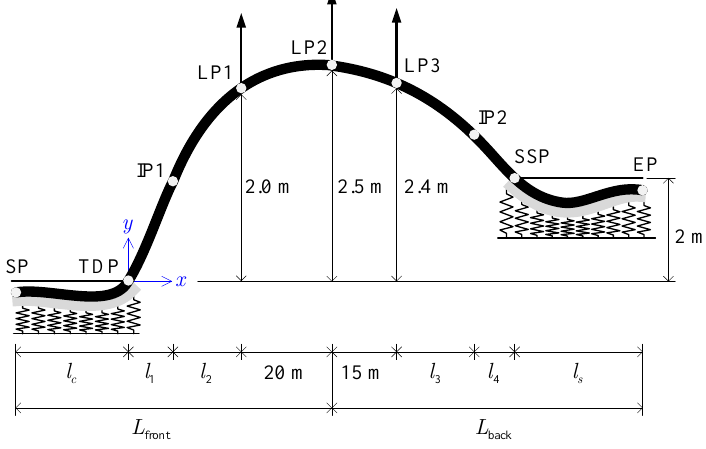
Figure A1. Schematic representation of the lowering-in phase with 3 of pipelayers